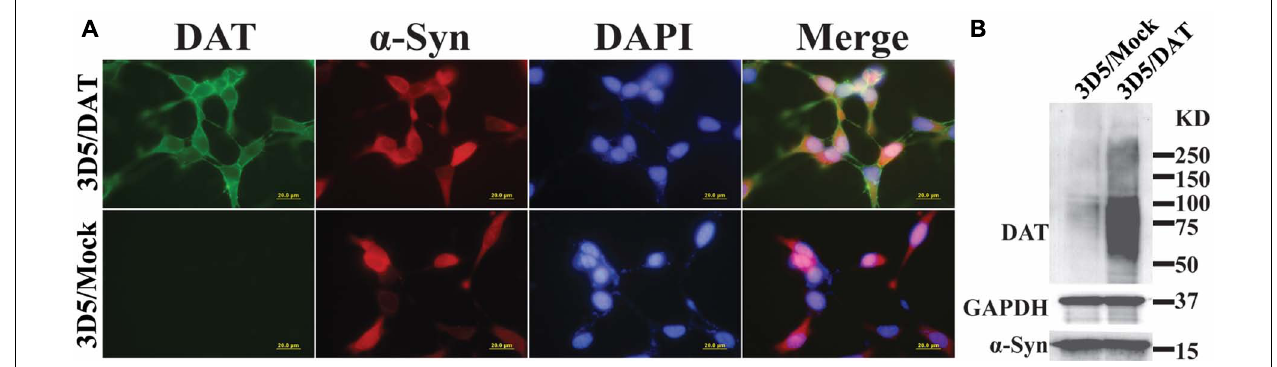
transfected cells, whereas mock transfected displayed only α -syn immunoreactivities. Nuclei of cultured cells were labeled by DAPI (blue). Western blotting demonstrated the presence of more DAT in lysates prepared from DAT transfected cells than those from mock transfected counterparts. The levels of α -syn or GAPDH in lysates from the transfected and mock transfected cells are